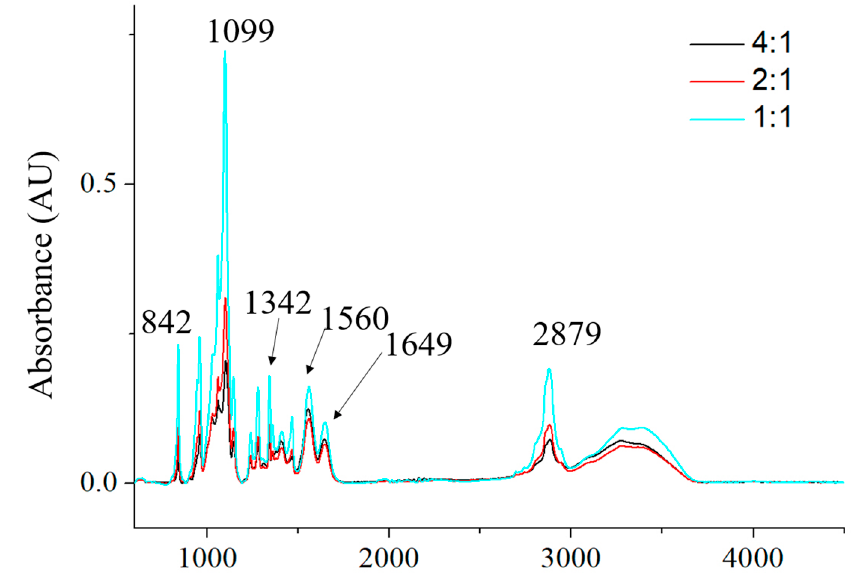
Figure 7. The FTIR-ATR spectra of the three different ratios of CCS/PEO nanofiber scaffolds.